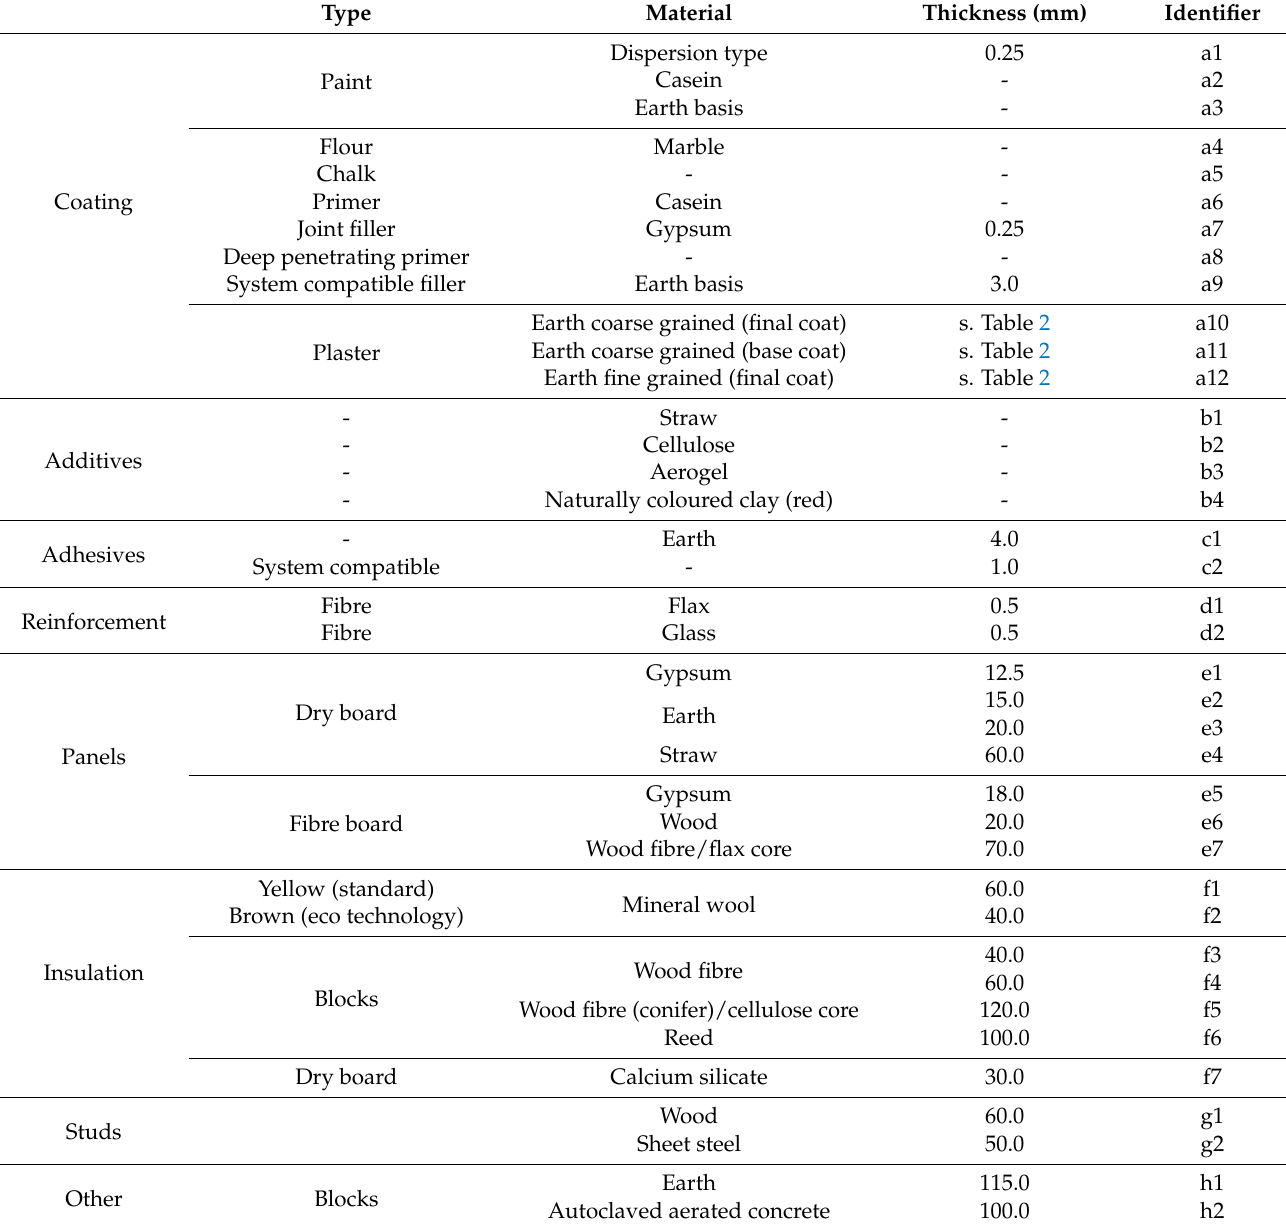
Table 1. Matrix of materials that are combined (combinations see Table